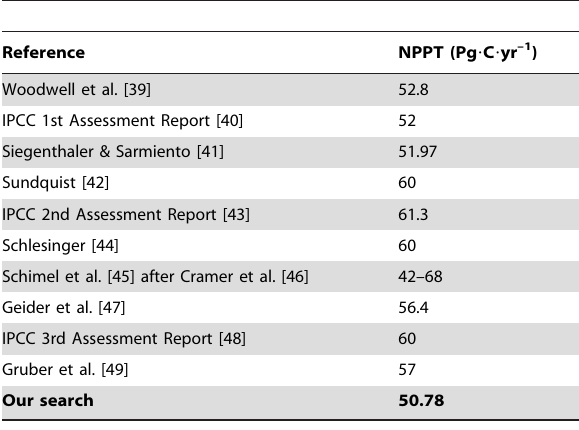
Table 2. Comparison of published values of present terrestrial net primary productivity (NPPT) and our research.